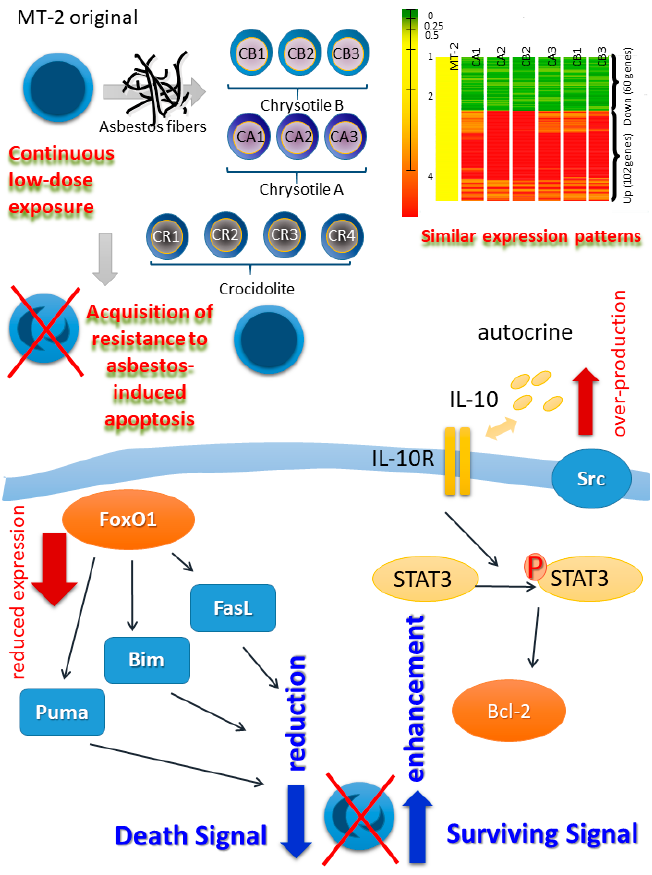
Figure 1. The effects of continuous and relatively low-dose exposure of asbestos fibers chrysotile A and B, and crocidolite were investigated using the human T cell leukemia/lymphoma virus (HTLV)- 1 immortalized MT-2 polyclonal T cell line. Following more than eight months of